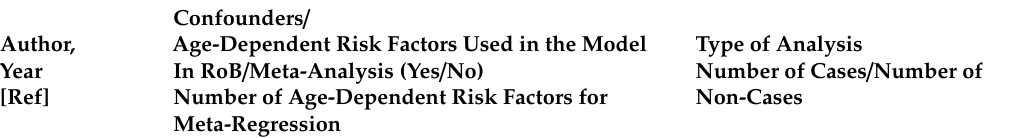
Table 3. Characteristics and results of included studies using composite measures of severe